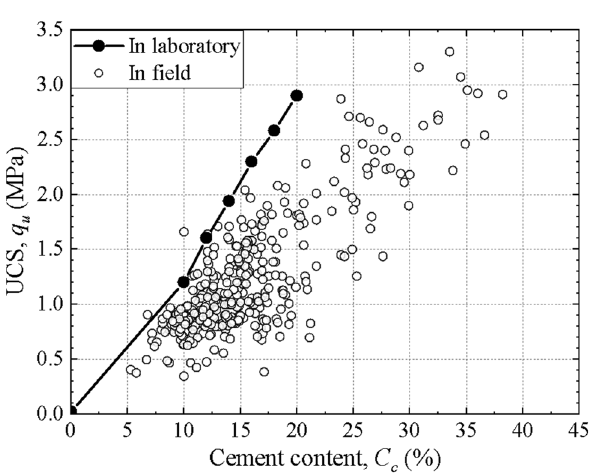
Figure 9. Relationship between UCS and cement content of specimens.